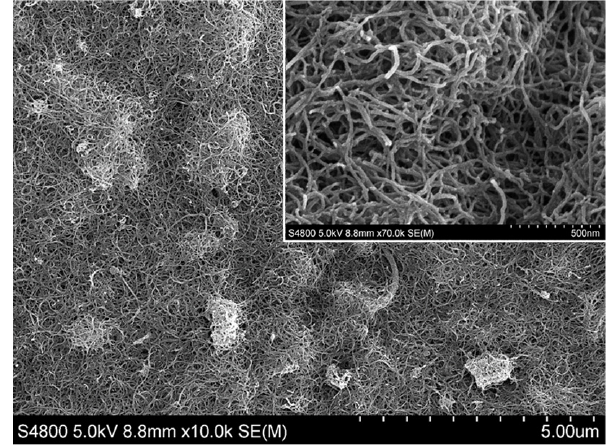
Figure 1. SEM image of multiwalled carbon nanotube–modified glassy carbon electrode (MWCNTs/GCE). A zoomed-in area is shown in the inset.